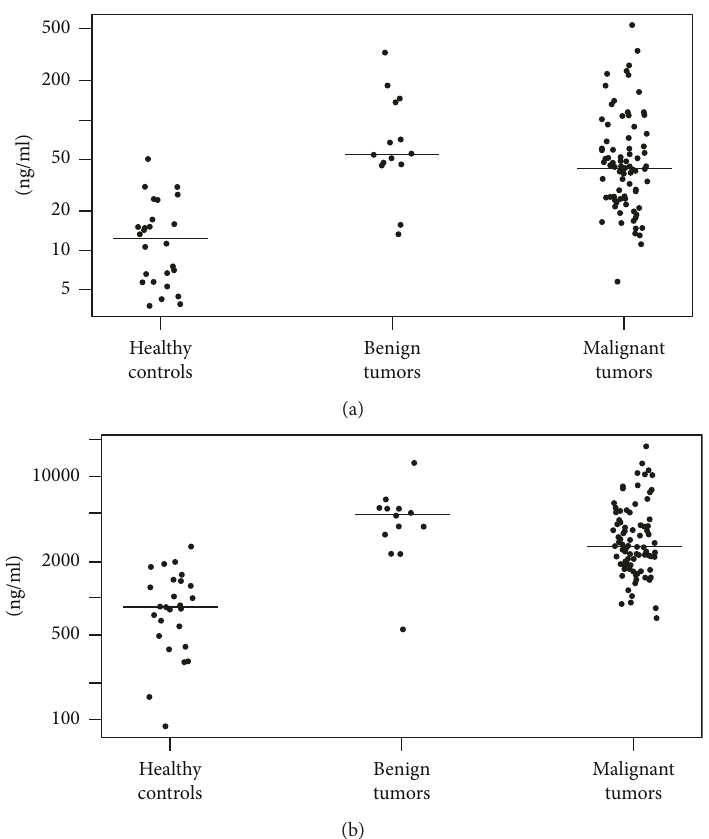
Figure 4: Calprotectin (a) and calgranulin C (b) baseline levels in patients with pancreatic tumors and healthy